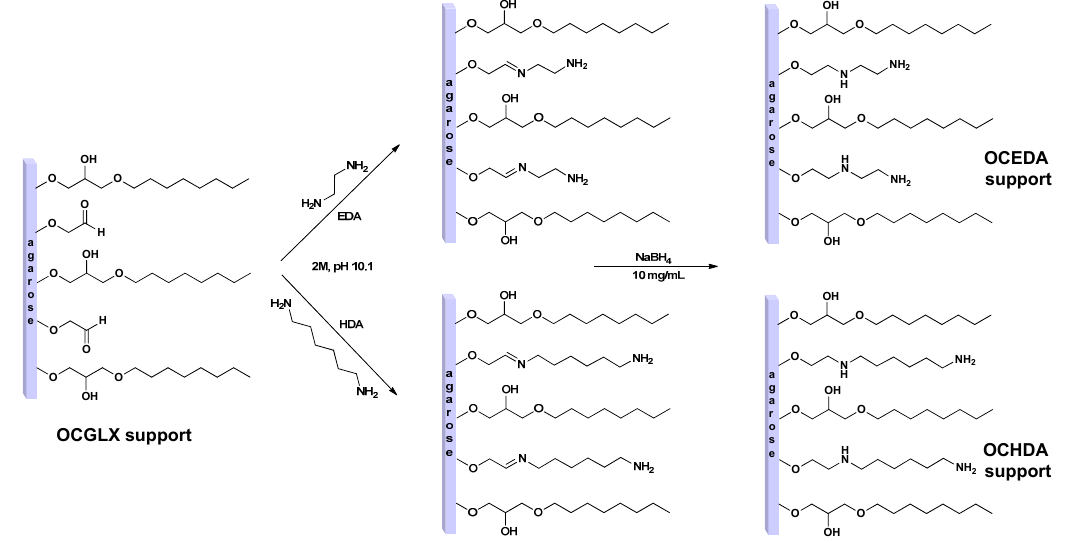
Figure 1. Preparation of different amino supports. Experiments have been performed as described in Section 2.